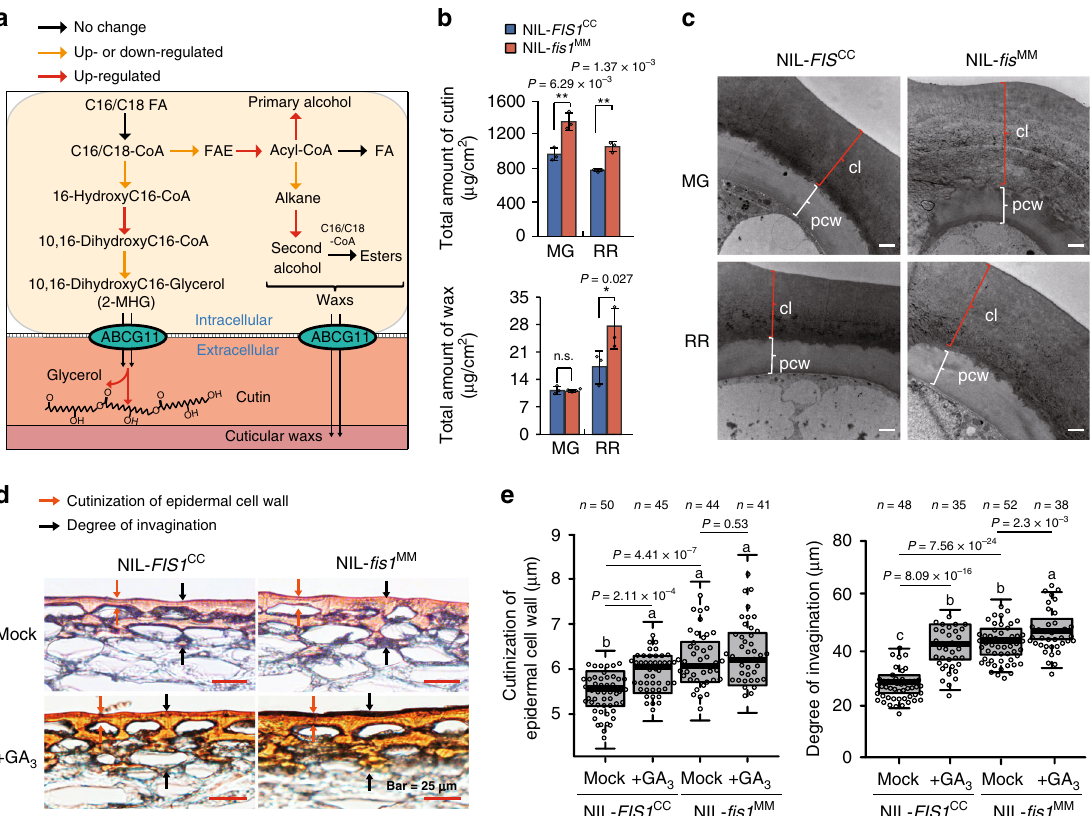
Fig. 4 FIS1 affects cuticle composition and deposition in tomato fruit pericarp. a Diagram of the cuticle biosynthesis pathway. Transcriptome data were obtained for NIL- fi s1 MM and NIL- FIS1 CC 30 DPA and breaker fruits, and the different colored arrows indicate changes in the expression level of known or putative cuticle-modifying genes that function at the indicated biosynthetic steps. The red arrows indicate that all DEGs related to this step were upregulated in NIL- fi s 1 MM . Orange arrows indicate that some DEGs related to this step were upregulated in NIL- fi s1 MM . The black arrows indicate that the transcript levels of structural genes did not differ between NIL- fi s1 MM and NIL- FIS1 CC . b Total cutin and wax content in the fruit pericarps of NIL- fi s1 MM and NIL- FIS1 CC . The asterisks indicate a statistically signi fi cant difference. Error bars, mean ± SD. n = three biological replicates. The asterisks indicate a statistically signi fi cant difference (two-tailed Student ’ s t -test, * P < 0.05, ** P < 0.01). n.s., no signi fi cant difference (two-tailed Student ’ s t -test, P > 0.05). MG, mature green; RR, red ripe. c Transmission electron microscopy images of NIL- fi s1 MM and NIL- FIS1 CC fruit pericarp sections. Bar = 2 μ m. MG, mature green; RR, red ripe. CL, cuticle layer; PCW, polysaccharide cell wall. Three independent experiments were performed. d Cuticle sections stained with Sudan IV to visualize the cutinization of epidermal cell walls and the degree of invagination with or without gibberellin treatment in NIL- fi s1 MM and NIL- FIS1 CC . Bars = 25 µ m. Six independent experiments were performed. e Quanti fi cation of the cutinization of epidermal cell walls and the degree of invagination at the red ripe fruit after GA treatment in NIL- fi s1 MM and NIL- FIS1 CC . n = section number. Box edges represent the 0.25 and 0.75 quantiles, and the bold lines indicate median values. Whiskers indicate 1.5 times the interquartile range. Different letters indicate signi fi cant differences according to the Tukey – Kramer test ( P <